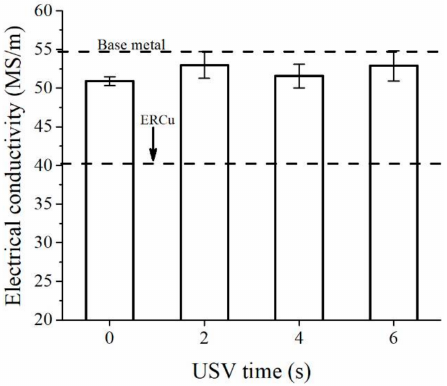
Figure 15. Electrical conductivity of the copper welded joint with and without assistance of USV in comparison with the electrical conductivity of standard welding filler ERCu.